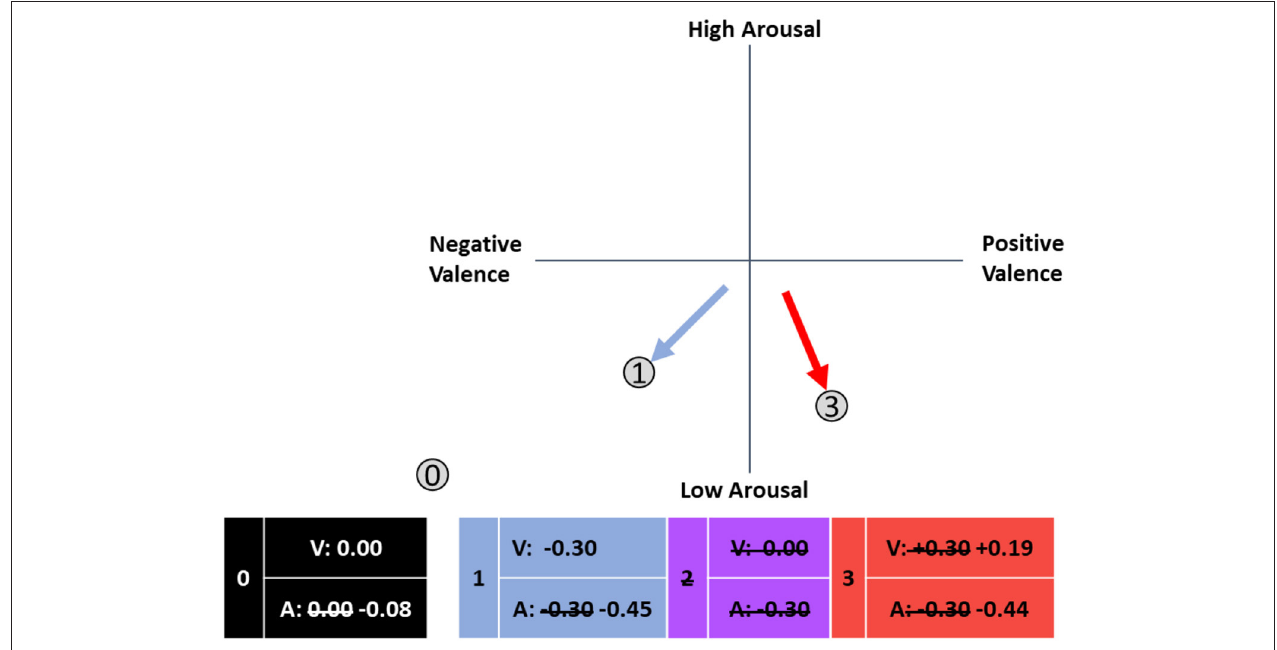
FIGURE 10 | Adapted framework of affective response categories in the circumplex model of affect (adapted from Russell, 1980).